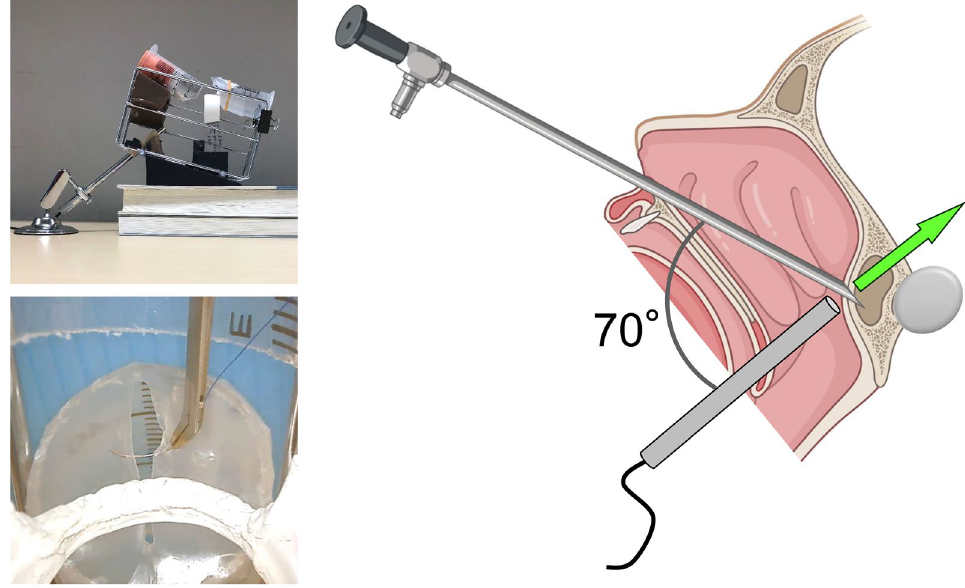
Figure 6. Observation of anterior skull base. This training kit can also simulate the vision of EndoArm with a camera with 70° field of view. The illustration was created with